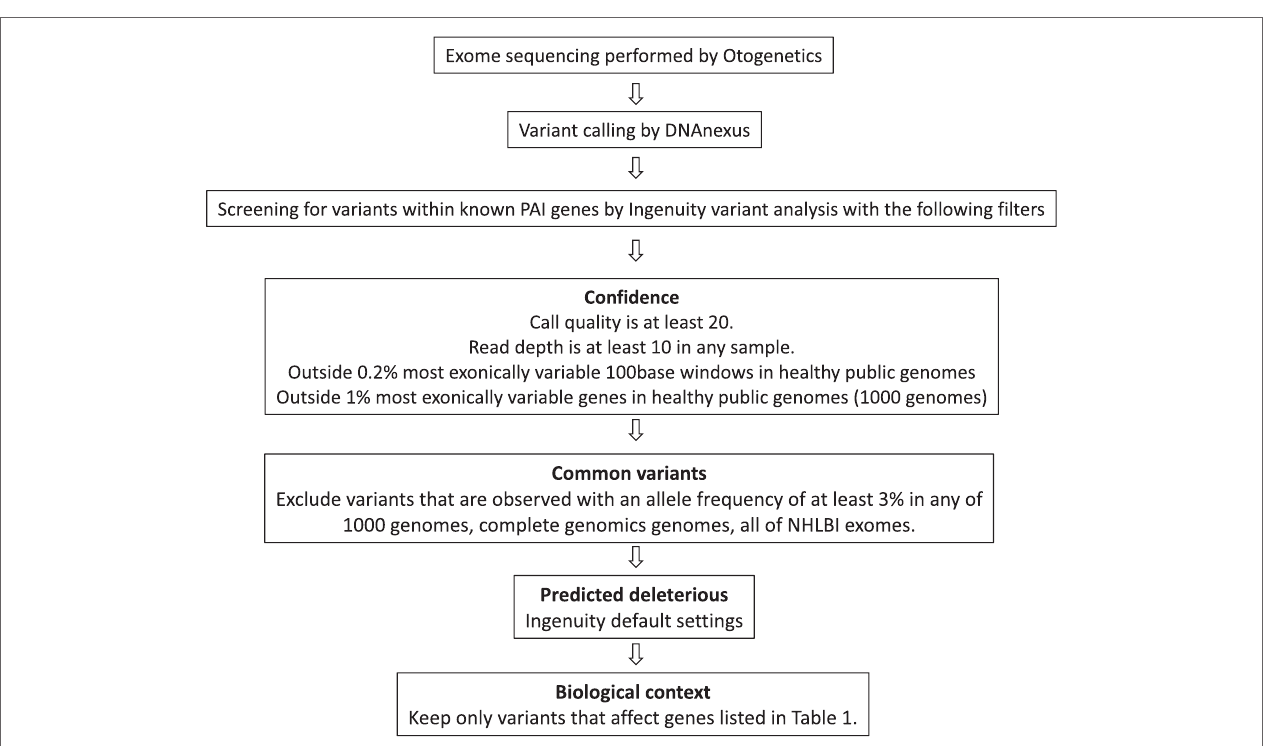
FigUre 2 | Filtration strategy to screen variants from Wes data